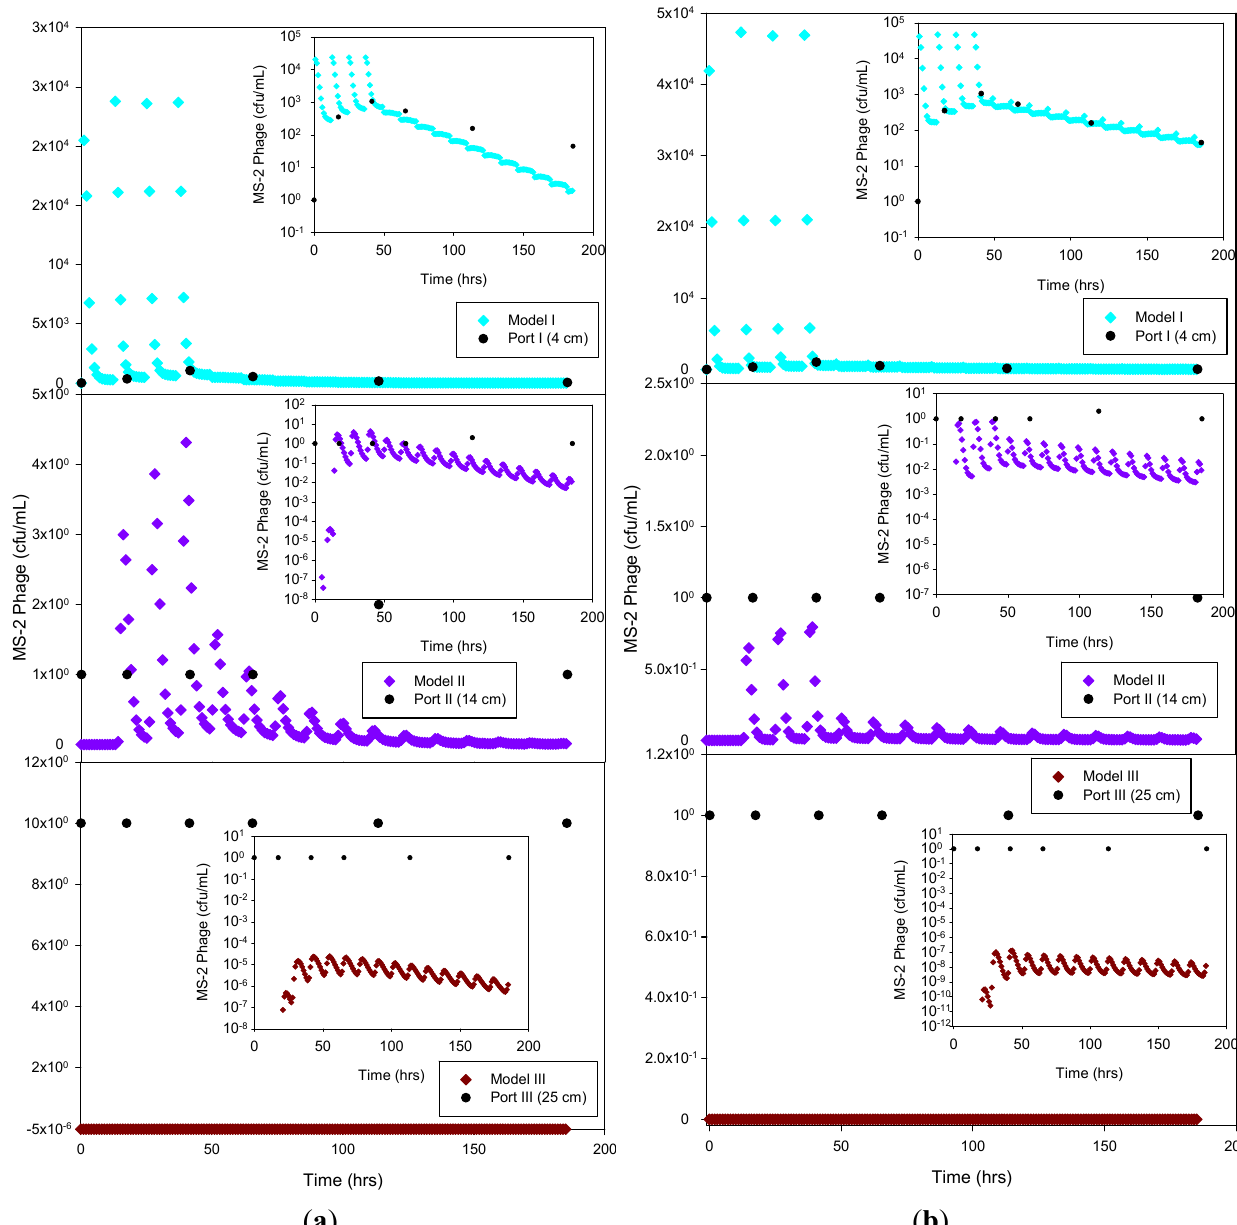
Figure 7. Experimental MS-2 phage data and HYDRUS optimization ( a ) and trial-and-error; ( b ) simulation for the sandy soil at 4 cm, 14 cm and 25 cm depth. The log-normal inserts emphasize the tailing